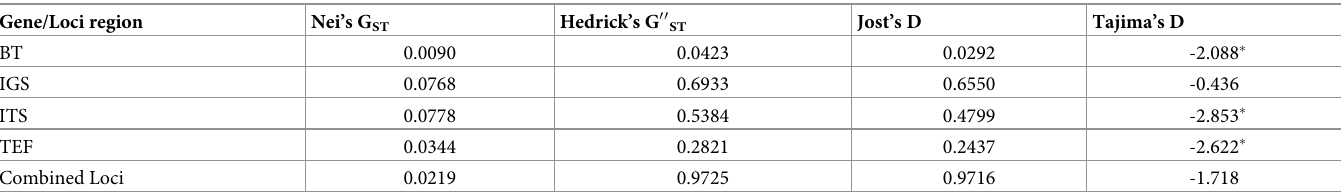
Table 4. Genetic differentiation statistics and Tajima’s D neutrality test a . Gene/Loci